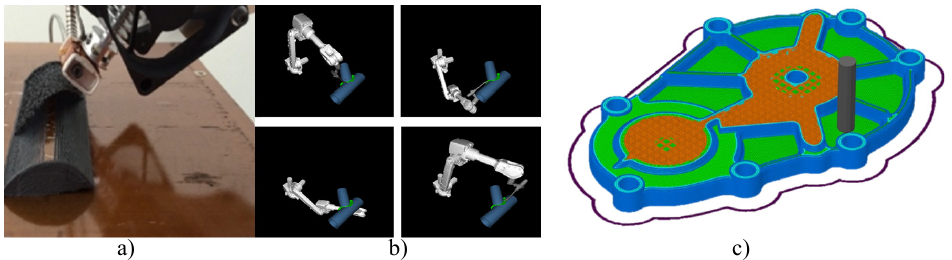
Figure 5. Example applications of path planning in AM: ( a ) AM of a hollow wing structure [7]; ( b ) path optimization with regard to heat input during welding [8]; and ( c ) slicing software Sim- plify3D with visible outer contour and filling structure